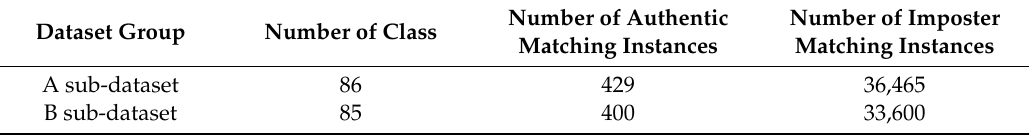
Table 4. Number of intra-class and inter-class for each dataset group.